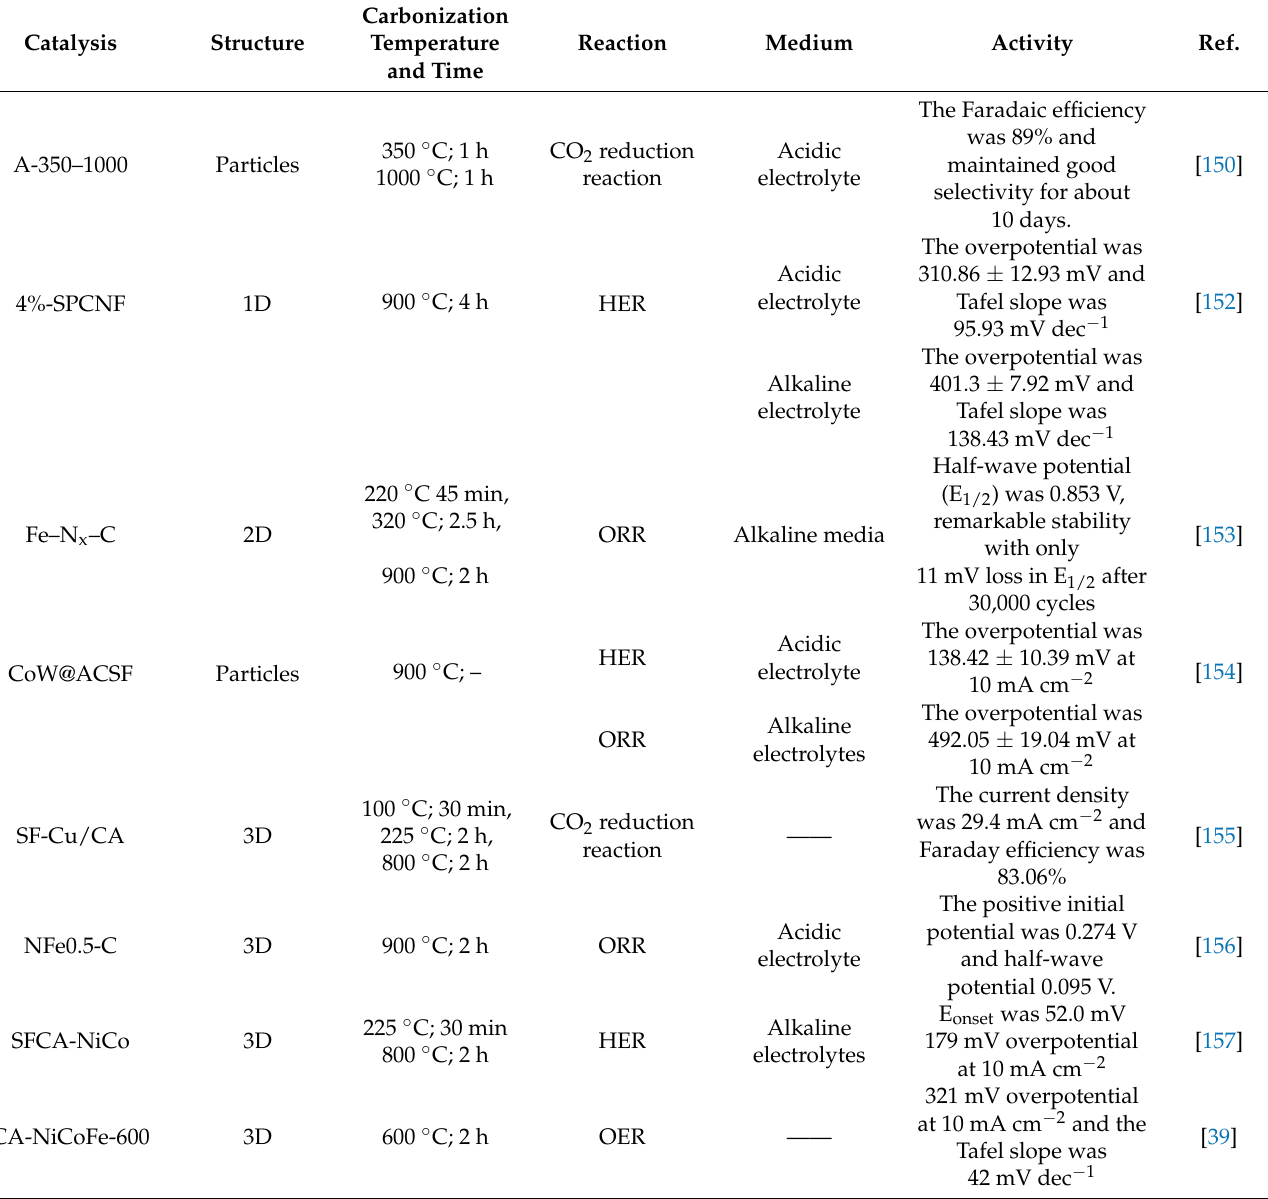
Table 3. Silk-derived carbon catalysts for